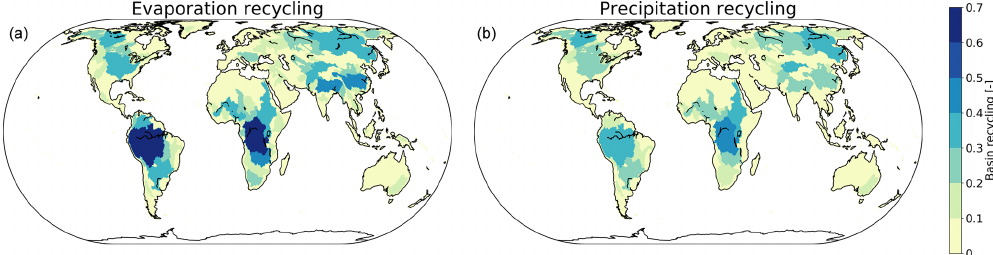
Figure 5. Average evaporation (a) and precipitation (b) recycling ratios per basin. The basin recycling ratios are plotted for the 26 largest river basins.